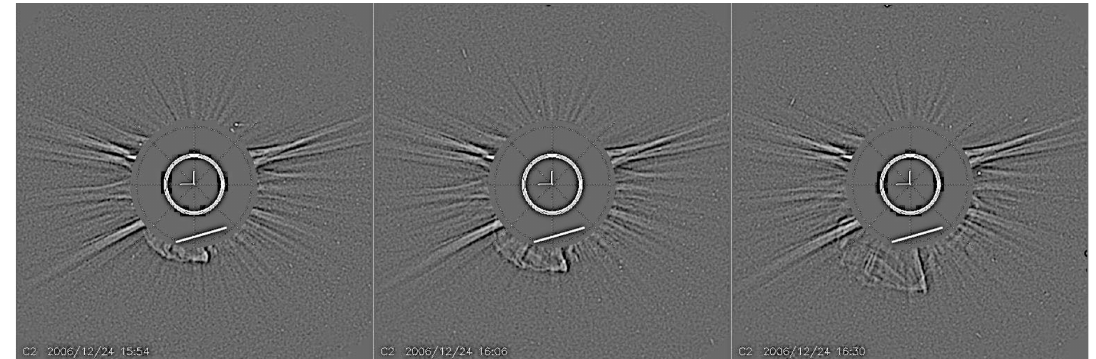
Figure 7. White light corona snapshots (wavelet filtered) acquired by LASCO C2 at 15:54, 16:06 and 16:30 UT on 24 December 2006, showing the evolution of the jagged and uneven front of the CME; the solar disk and the UVCS slit are also